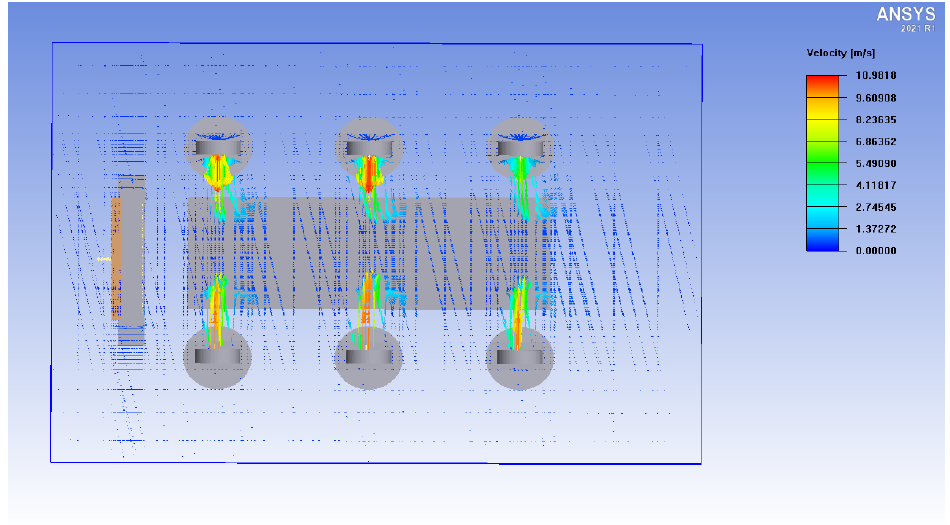
Figure 27. Air purifier simulation top view in the conference room at a low rotation speed -1.